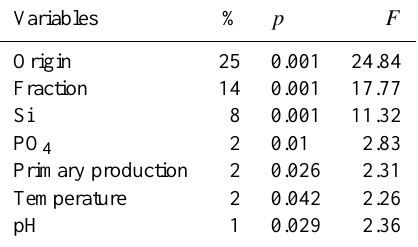
Table 1. Redundancy analysis showing the significant structur- ing variables for the whole bacterial community during the post- nutrient addition period ( t 13– t 30). Significant values are p < 0 . 05.